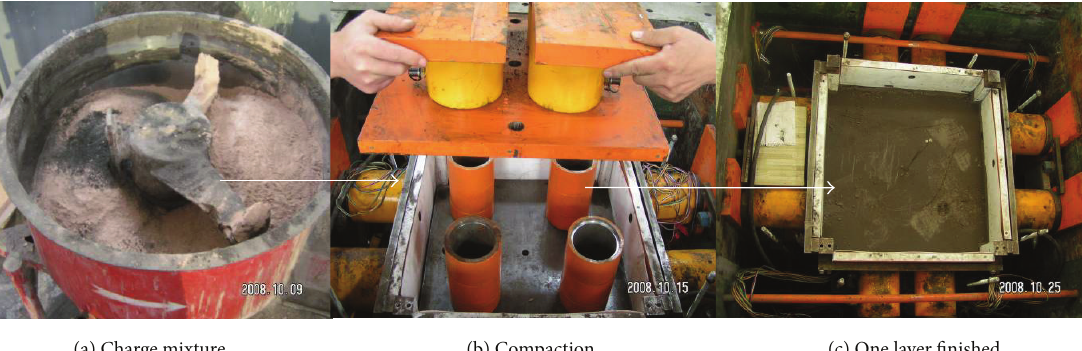
Figure 8: Procedure of the model building.